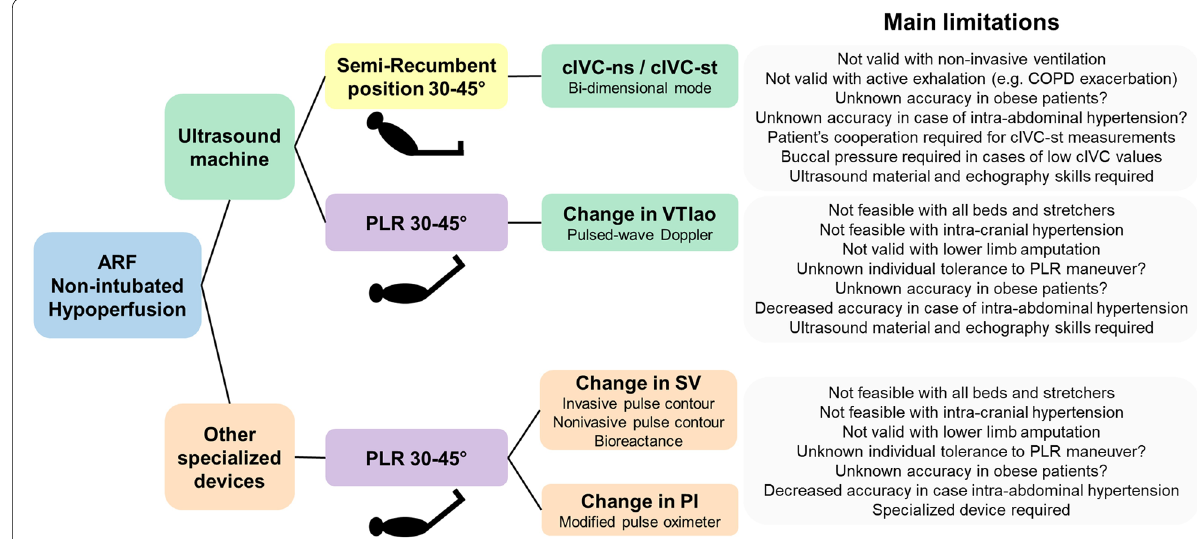
Fig. 1 How to predict fluid responsiveness in non-intubated patients with hypoperfusion and acute respiratory failure (ARF). cIVC collapsibility index of the inferior vena cava with standardized (-st) and unstandardized (-ns) inspiratory manoeuver, COPD chronic obstructive pulmonary disease, PI perfusion index, PLR passive leg raising, VTIao velocity time integral of aortic blood